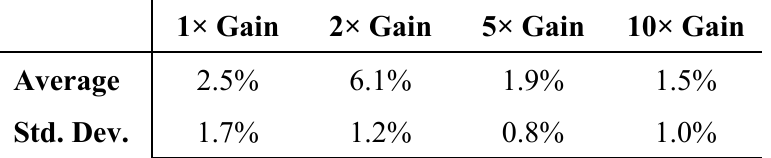
Table 2. Percentage difference between the results from the PXIe-6124 measurements and the Underwater Sound Recorder measurements for the underwater explosion